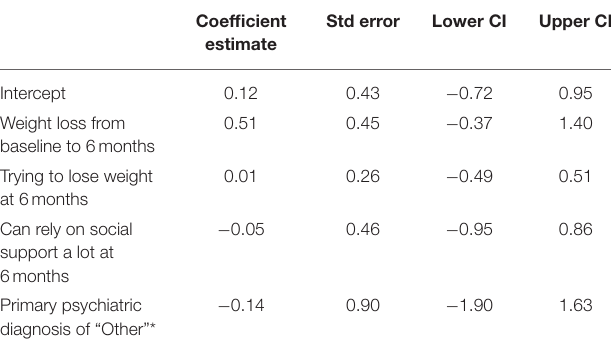
TABLE 2 | Resulting model from Lasso